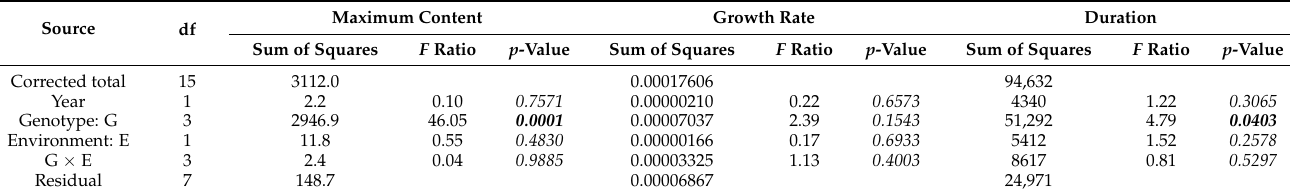
Table 2. Analyses of Variance for the Estimates of β -glucan Content (mg/g) Deposition Parameters: Maximum Content, Growth Rate and Duration.